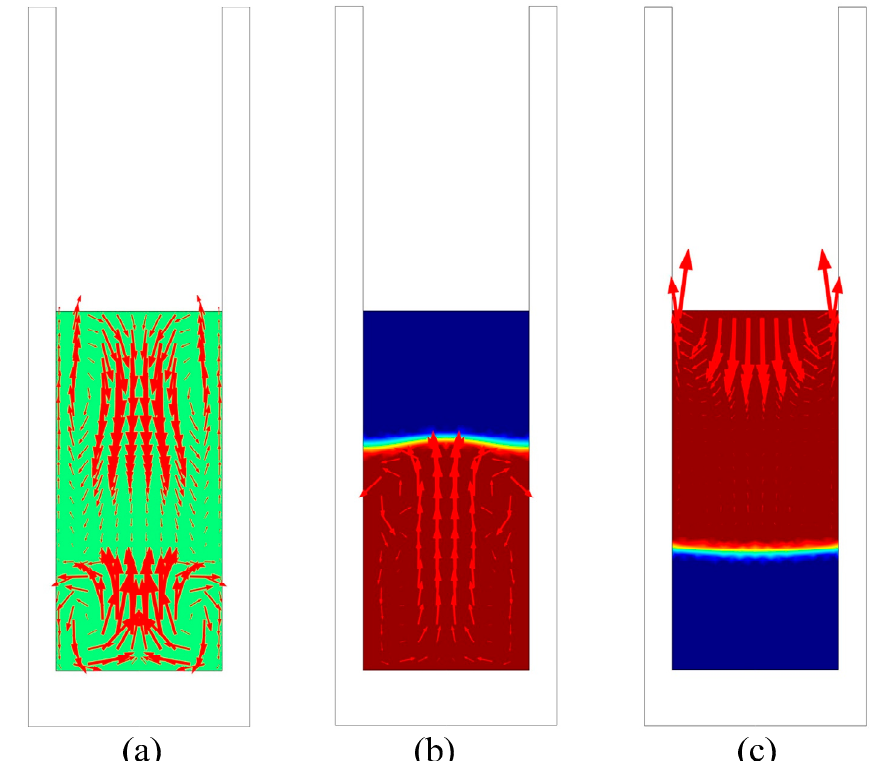
Figure 4. Fluid flow simulation results: ( a ) At the initial sample position, ( b ) after pulling the sample up to a certain position, and ( c ) after pulling the sample down to a certain position during EMDS.